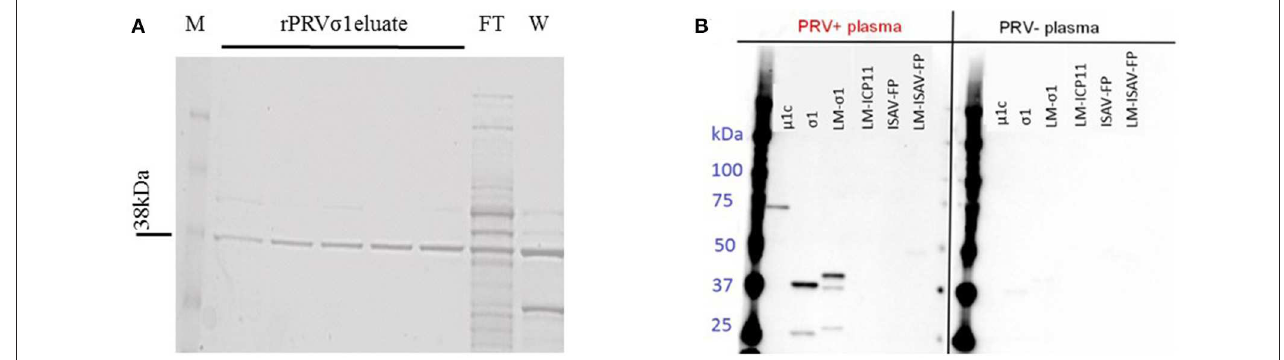
FIGURE 1 | Production of lipid modified PRV proteins. (A) SDS-PAGE profile showing the purified lipid-modified PRV σ 1 (M-Marker, FT-Flow through, and W-Wash). Eluates 1–2 with 25mM imidazole and 3–5 with 50mM imidazole elution. (B) Specificity of plasma IgM to PRV antigens. Proteins used in the multiplex immunoassay were analyzed by western blotting. Left panel incubated with plasma from PRV-infected Atlantic salmon (pooled sample from 10 to 15 wpc) and right panel incubated with plasma from control fish (pooled samples from the same challenge trial) as primary antibody.